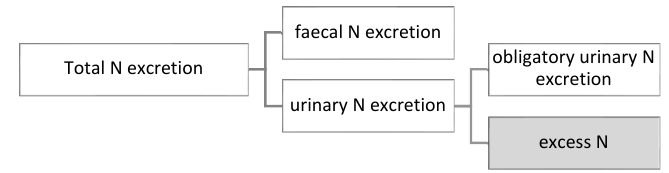
Figure 2. Partitioning of nitrogen excretion.